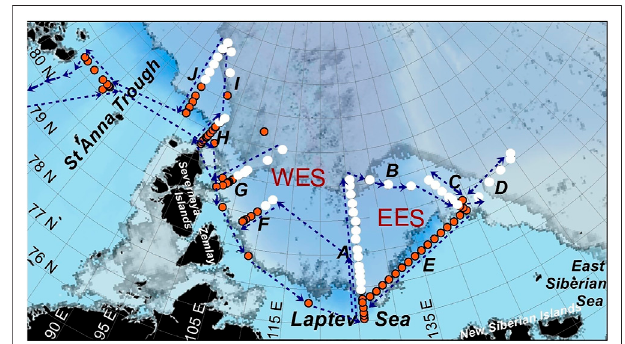
FIGURE 1 | Sea ice concentration [University of Bremen, (Spreen et al., 2008)]onAugust15th(lightgrey/transparent)andSeptember15th(darkgrey/ transparent)isshowntogetherwithsamplingsitesinopenwater(red)andice- covered (white) regions. Blue arrows indicate the track of the R/V “ Akademik Fedorov ”